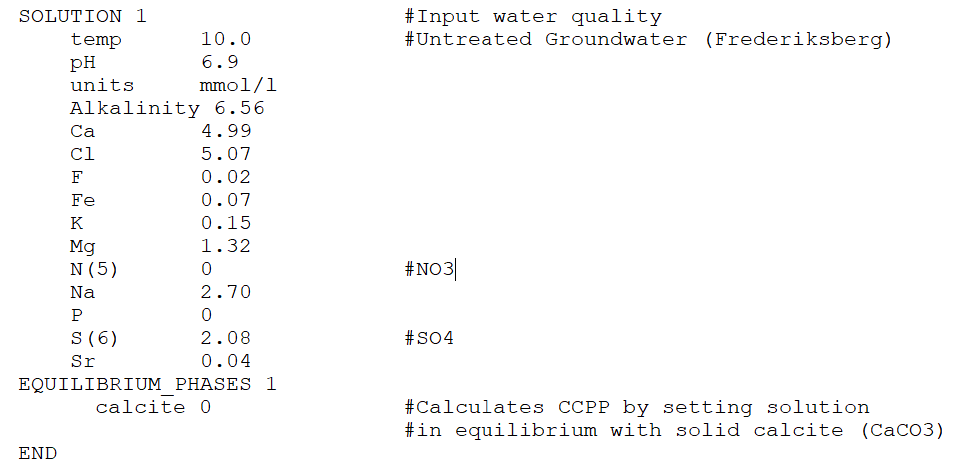
Figure A1. Example PHREEQC input file for calculating CCPP at the sample temperature.